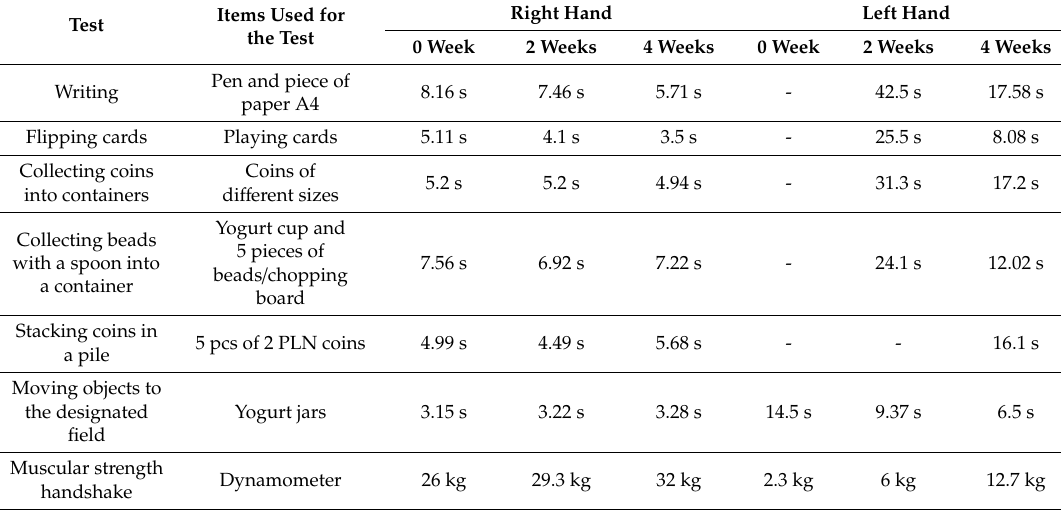
Table 1. Results of patient